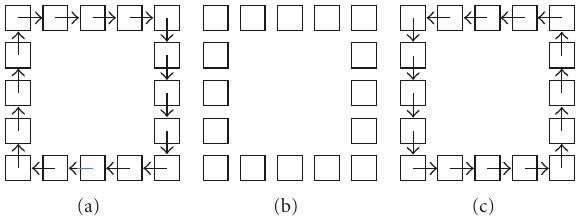
Figure 18: Swing broadcasting allows distributing of boundary conditions in (a) three steps clockwise and (c) anticlockwise. (b) For proper functionality on the duplex lines, a separating idle step is introduced.